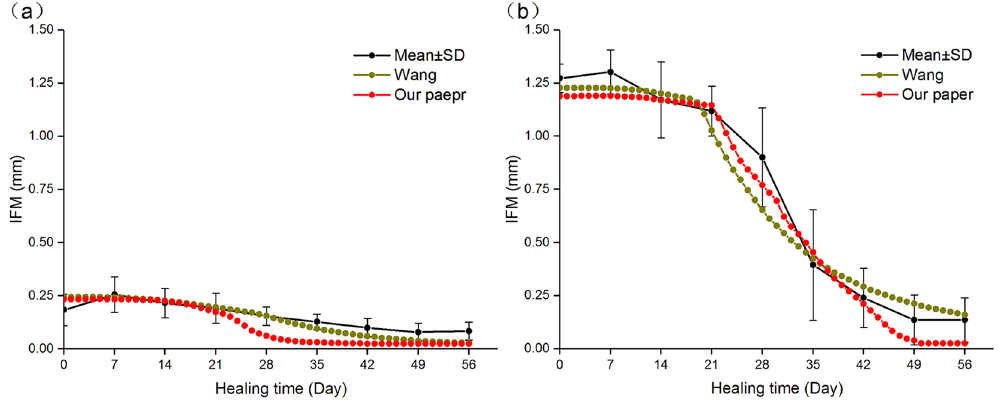
Figure 4. Comparison of IFM between average values of experimental data, Wang’s simulated results and our simulated results.